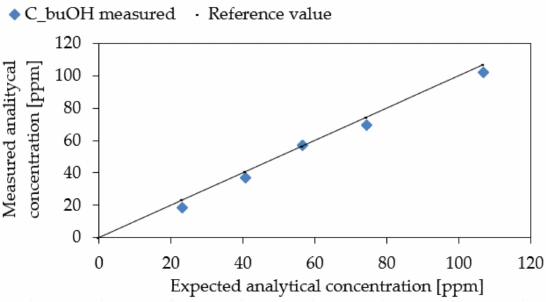
Figure 8. Scatter diagram of between concentration of butanol measured by the chromatograph (C yOH expressed in ppm of butanol) and the concentration expected due the generation process at 140 ◦ C (C xOH expressed in ppm of butanol) obtained during the second field trial.